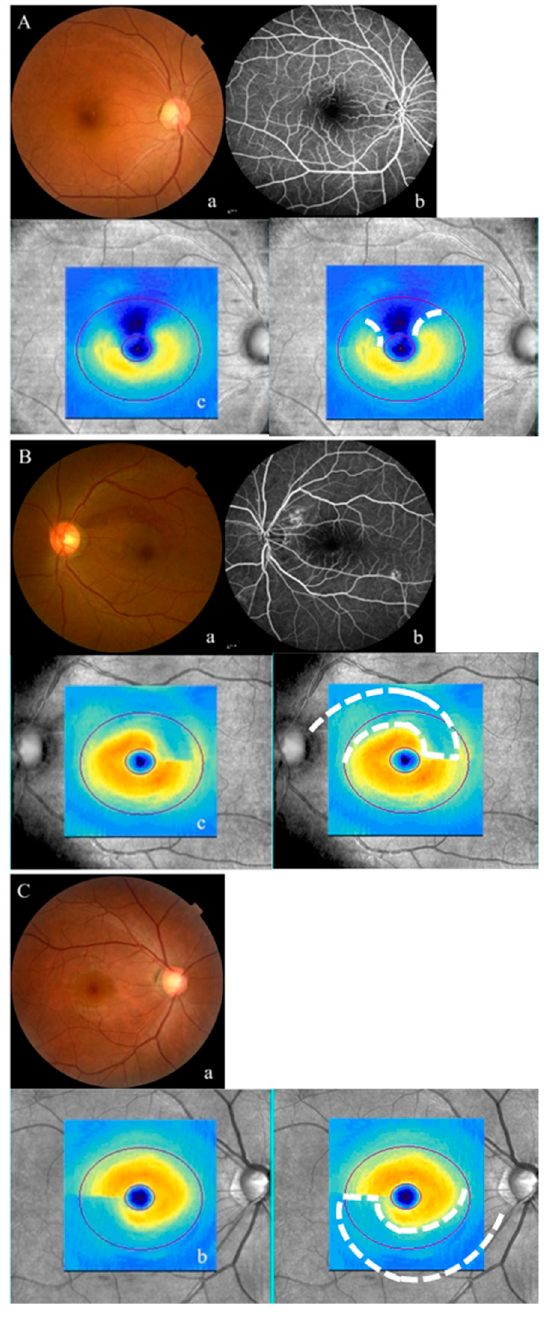
Figure 1. Representative cases from each patient group: patients ( A ) and ( B ) have retinal vein occlusion (RVO) and patient ( C ) has primary open-angle glaucoma (POAG). In patient ( A ), a fundus photograph (a) shows a superotemporal retinal nerve fiber layer (RNFL) defect. Fluorescein angiography (b) shows superiorly localized abnormal retinal vessels and small fovea non-perfusion. The thickness map of the ganglion cell analysis (GCA) (c) shows non-arcuate and interrupted ganglion cell-inner plexiform layer (GCIPL) thinning with blue/black color in the superior hemisphere. In patient ( B ), a superotemporal RNFL defect (a) and corresponding regularly arcuate GCIPL thinning on the thickness map (c) are shown. Mild leakage of the fluorescein from an abnormal retinal vessel localized in the superotemporal peripapillary area is shown (b). In patient ( C ), an inferotemporal RNFL defect (a) and corresponding regularly arcuate GCIPL thinning (b) are shown.